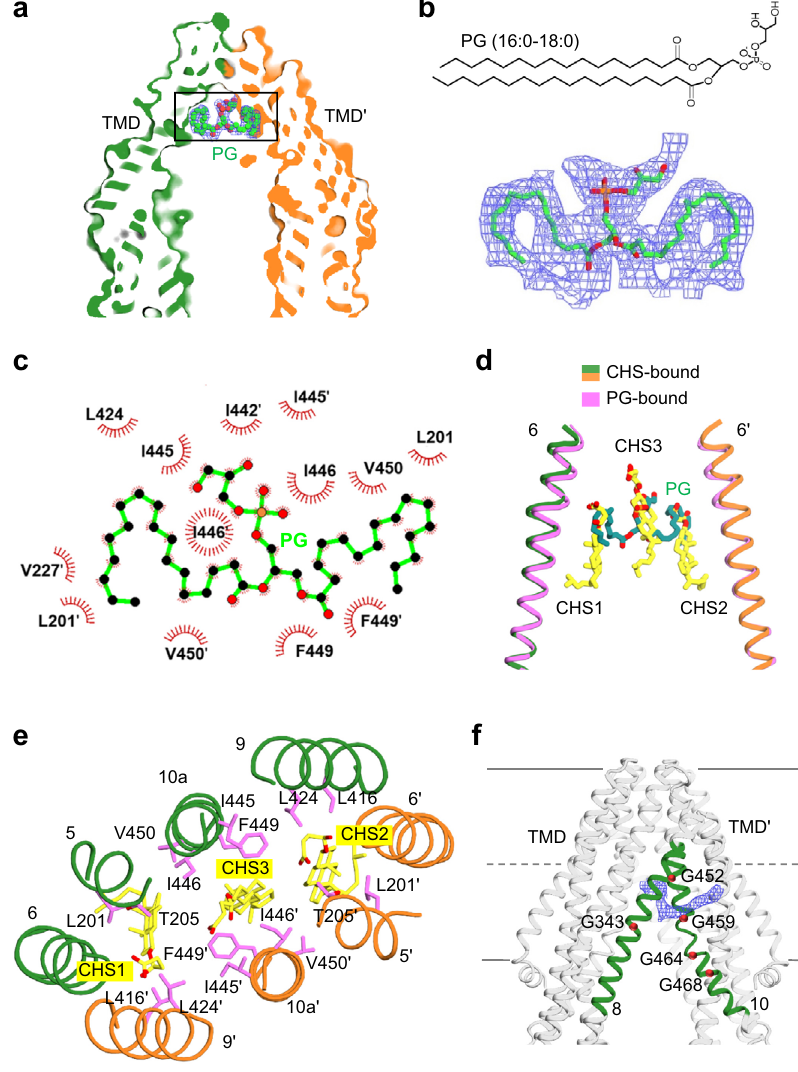
Fig.6|Lipidbindingsite.a Surfaceslabviewofinward-facing Δ TMD0innanodisc. A PG (16:0 – 18:0) molecule bound in the upper cavity is represented by a space- fi lling model. The EM density of the bound PG is shown at 3.5 σ level. Carbon, oxygen, and phosphorus atoms are colored green, red, and orange, respectively. Zoom-in view of the boxed region is presented in ( b ). b The chemical structure (top) and EM density (3 σ level, bottom) of bound PG. c Interactions between Δ TMD0 and PG were analyzed with LigPlot+ software. The PG (green) is shown in ball and stick representation. Residues involved in nonpolar and van der Waals